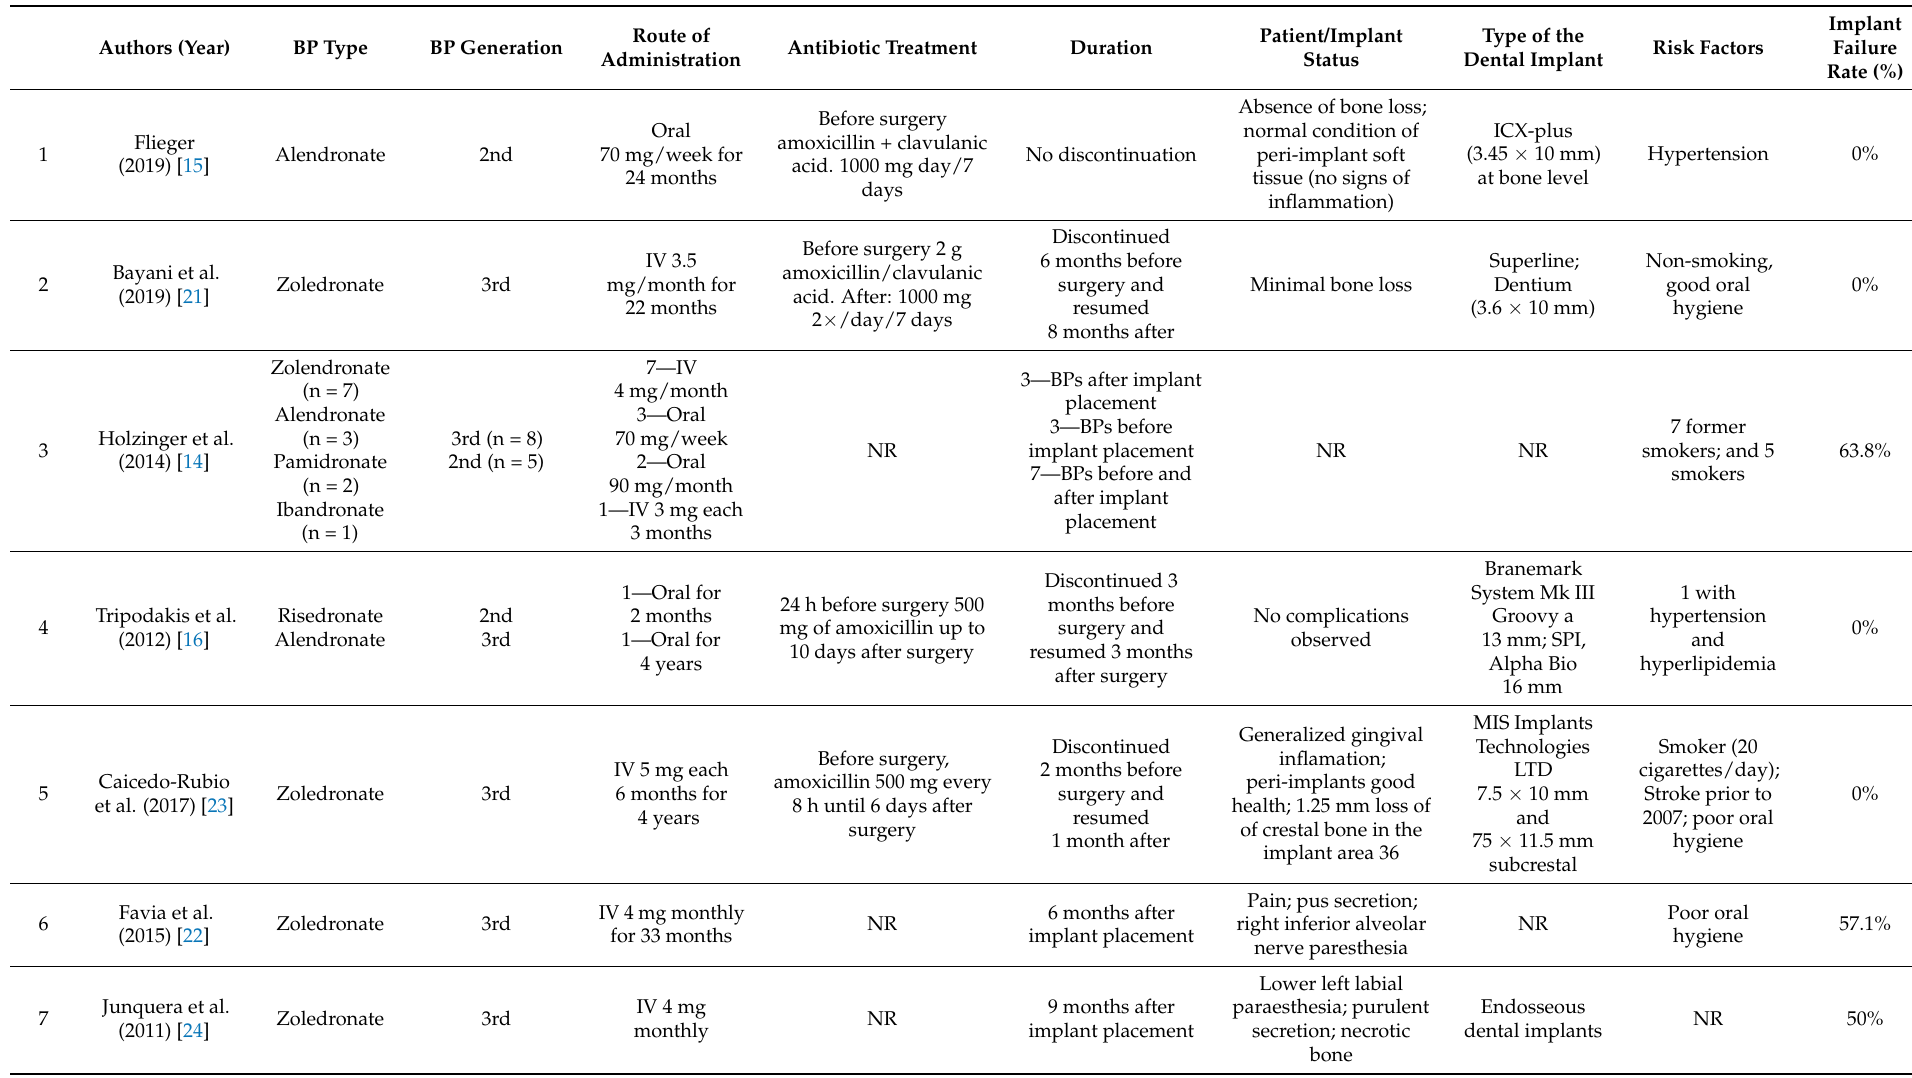
Table 4. Comparison of the characteristics of the variables